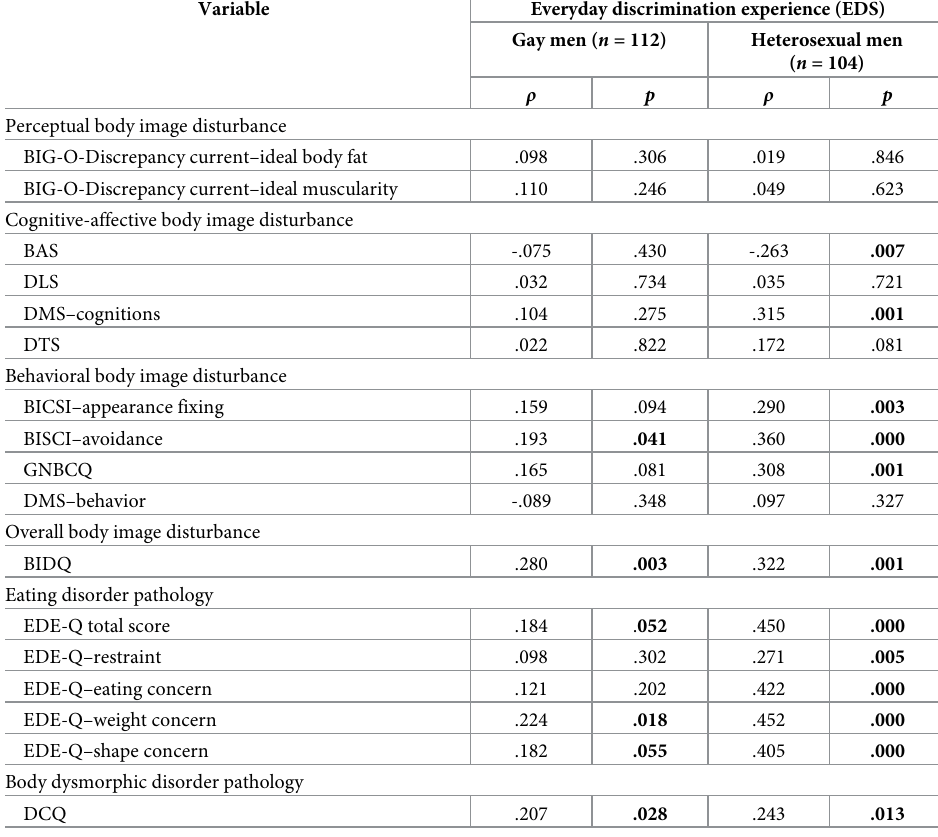
Table 5. Correlations of everyday discrimination experiences with body image disturbance facets, eating disorder pathology and body dysmorphic disorder